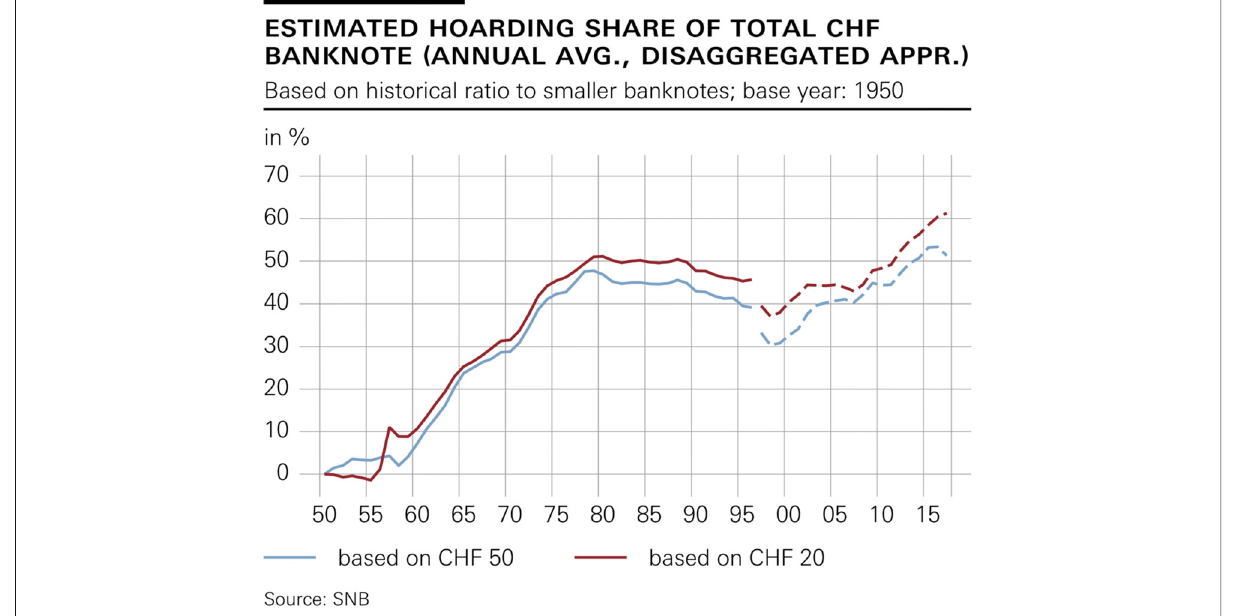
Fig. 6 Method based on ratios - results for total banknotes